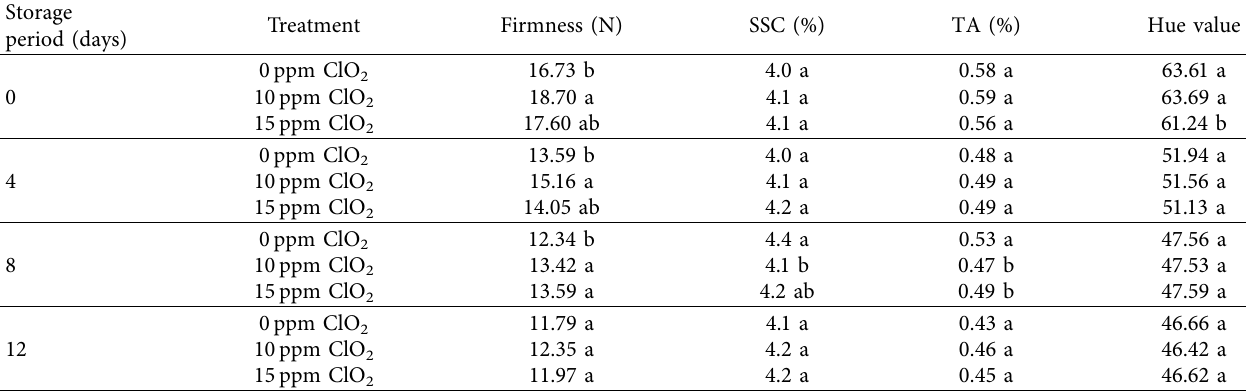
Table 1: Efect of ClO 2 treatment on quality (frmness; SSC: soluble solid content; TA: titratable acidity) and color (Hue values) in fruits stored at 13 ° C for 12 days.